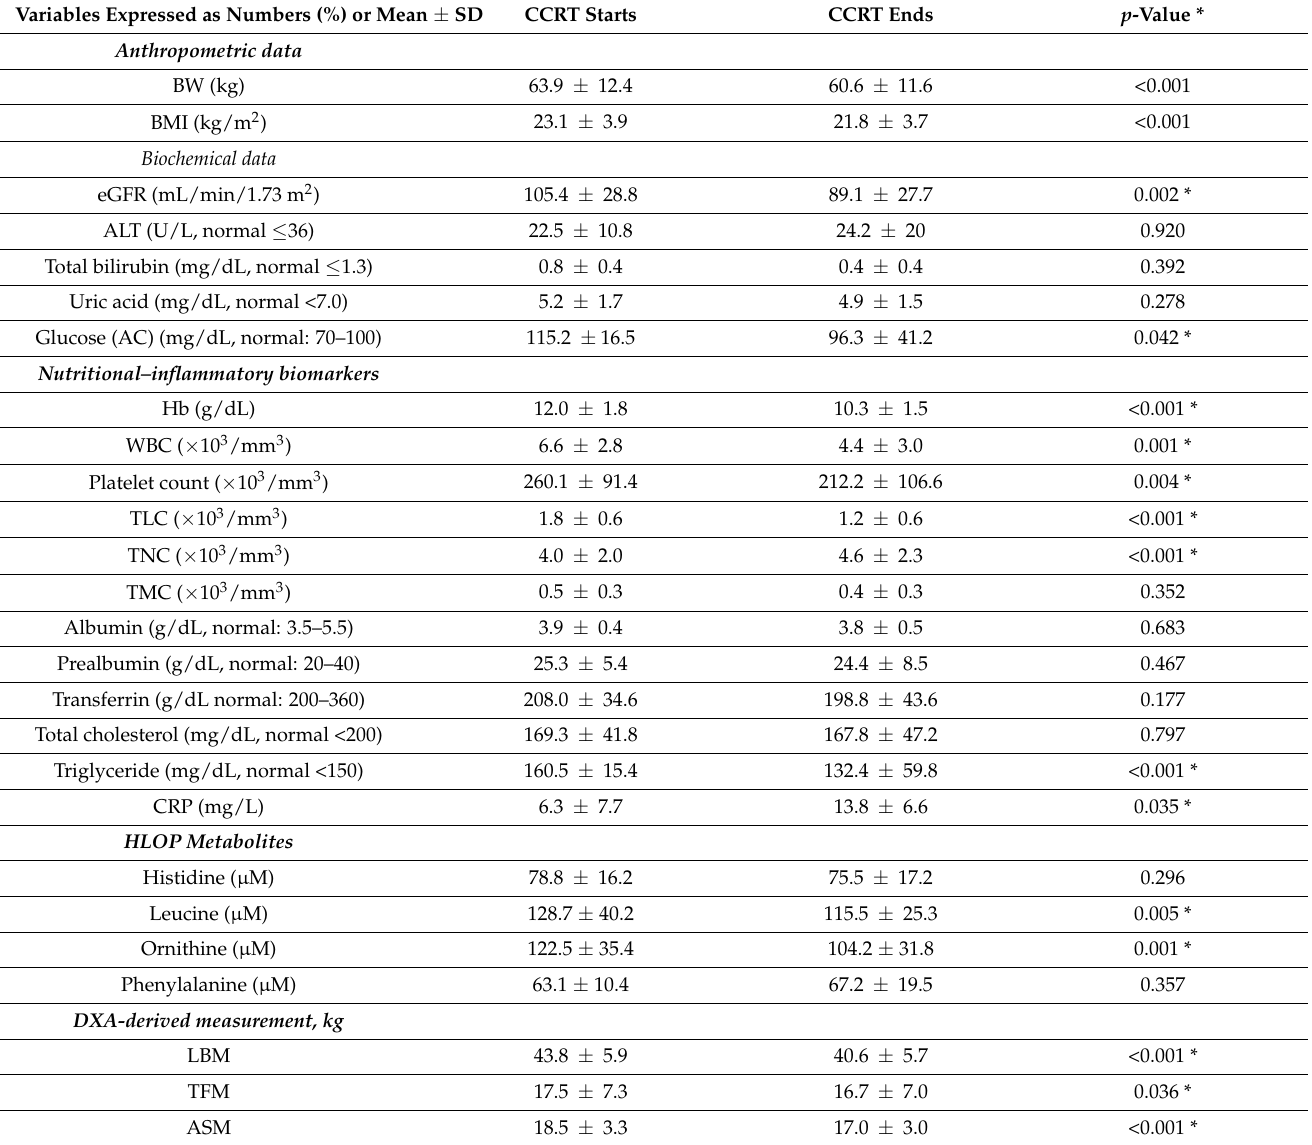
Table 2. Treatment-interval changes of anthropometric data, NIBs, serum HLOP metabolites, and DXA- derived body composition measurements in 44 patients with LAHNSCC following CCRT